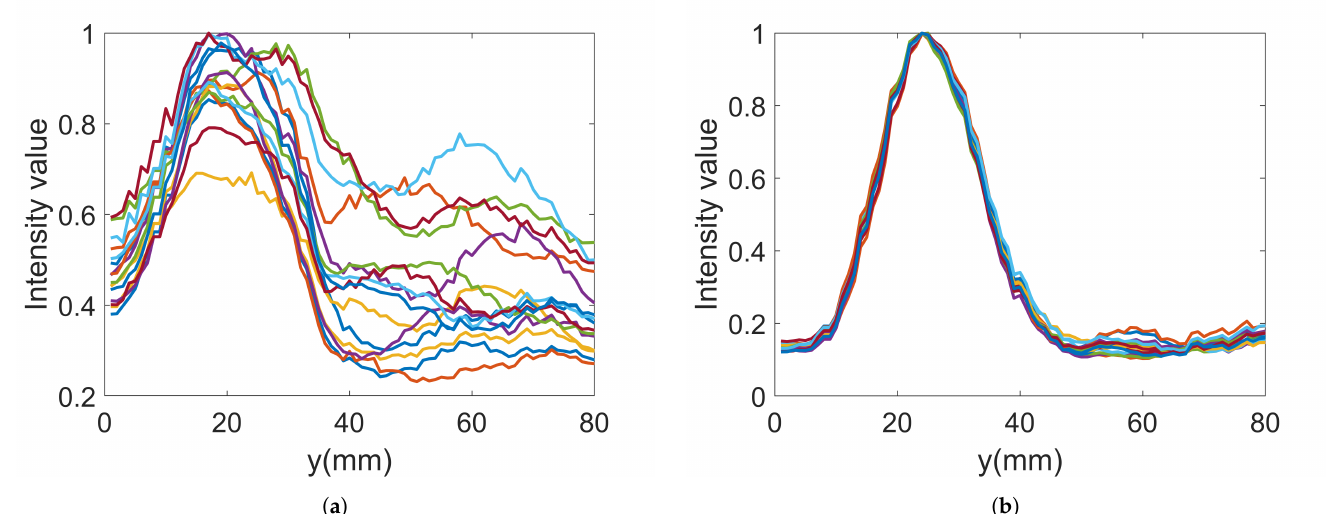
Figure 15. Reconstructed data along the line through the center of the imaging domain for 15